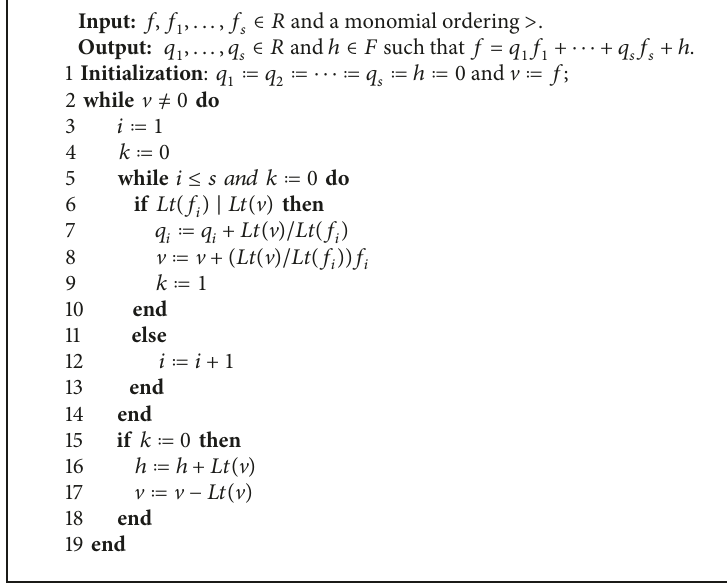
Algorithm 1: Division’s